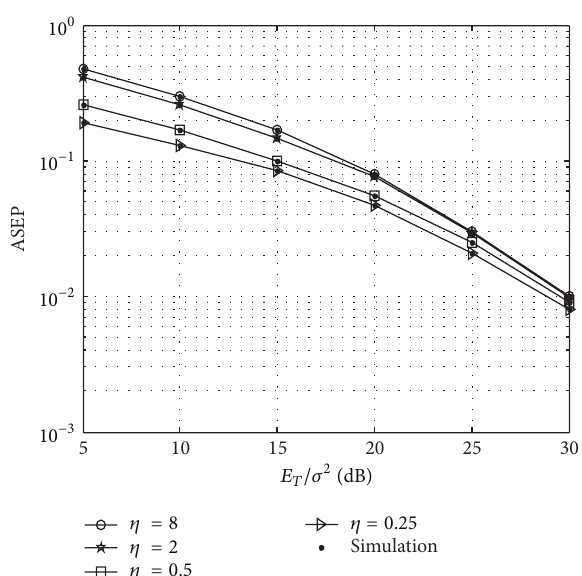
Figure 2: ASEP of 2 × 2 MIMO system for 16-QAM using MMSE- OSIC over Rayleigh fading channel with arbitrary values of 𝜂 .